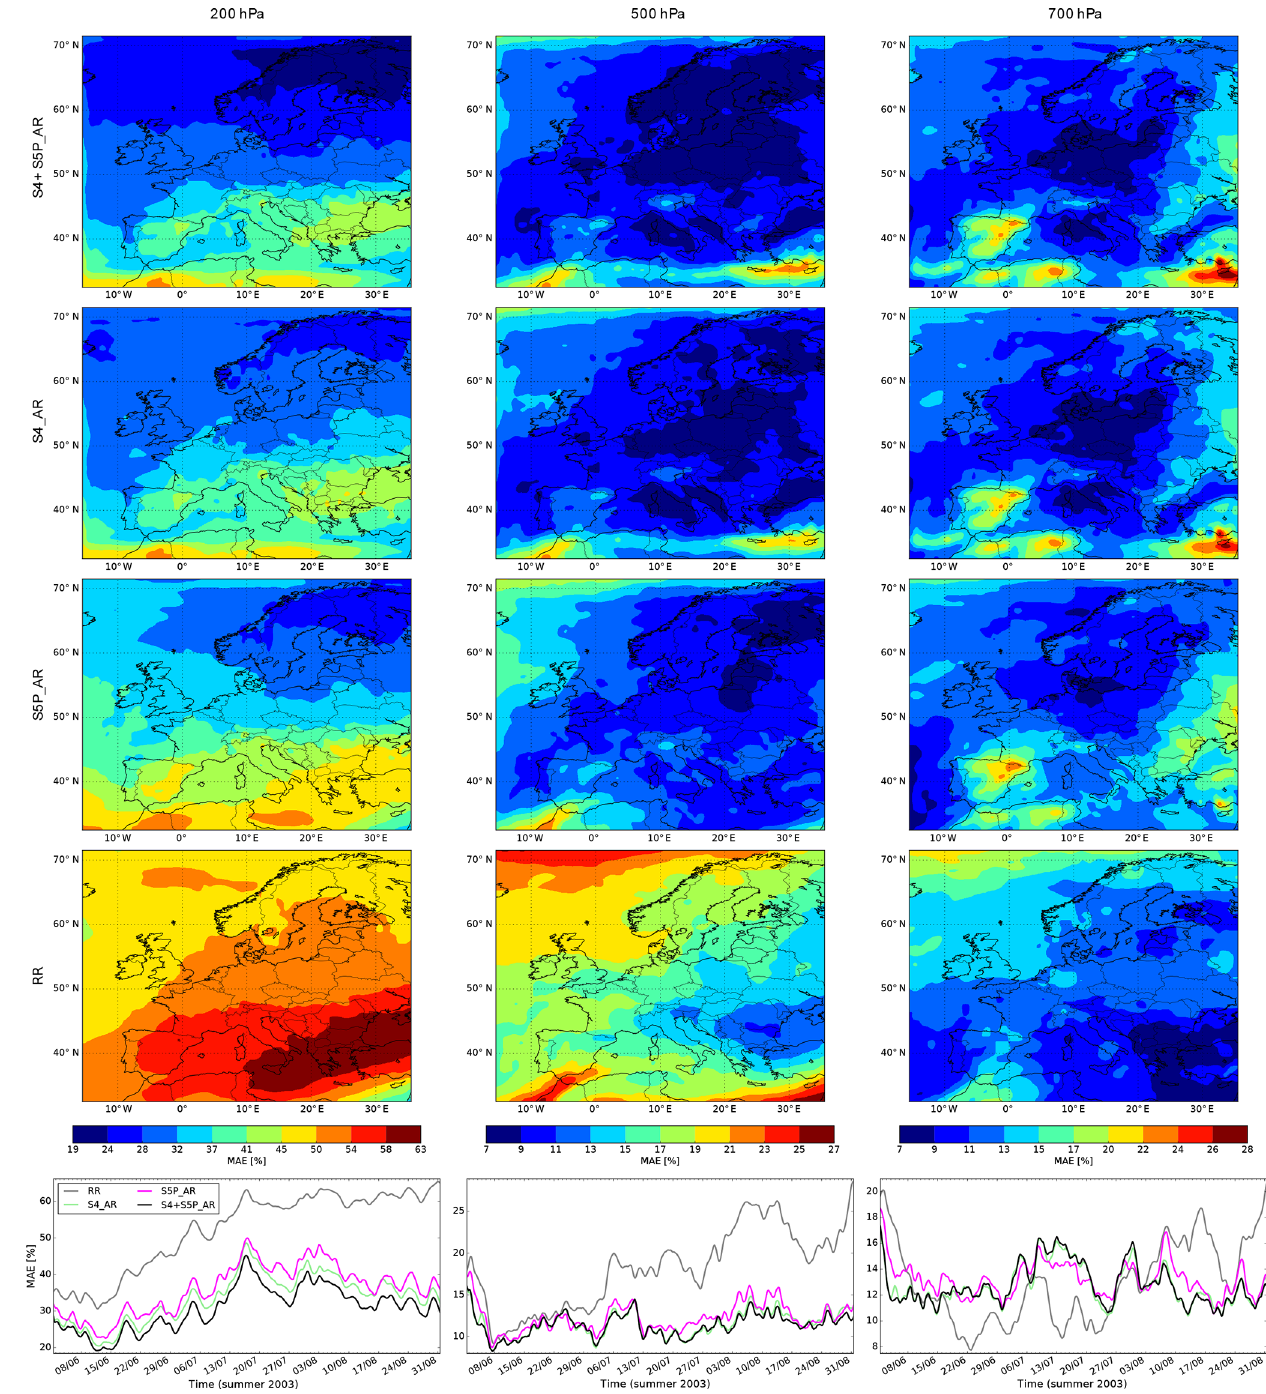
Figure 10. Mean absolute error (MAE) fields (%) for summer 2003 over the European domain at 200hPa (left column), 500hPa (middle column), and 700hPa (right column), and for the S4+S5P_AR, the S4_AR, the S5P_AR, and the reference run (from top to bottom, first to fourth rows) compared to the nature run. Note that the colour bars for the three levels are different. The red (blue) end of the colour scale represents relatively large (small) MAE values. The bottom row represents the MAE (%) time series for summer 2003 over the European domain at 200hPa (left column), 500hPa (middle column), and 700hPa (right column) as provided by the reference run (grey lines), the S4_AR (green lines), the S5P_AR (magenta lines), and the S4+S5P_AR (black